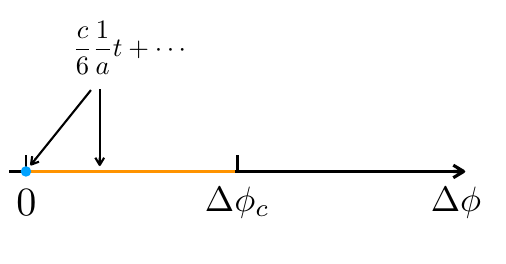
Figure 30 . The leading time evolution of the pseudo entropy in the small ∆ φ phase. The blue point ∆ φ = 0 is a case that we know the precise answer, while the behavior at the orange region remains to be a conjecture.